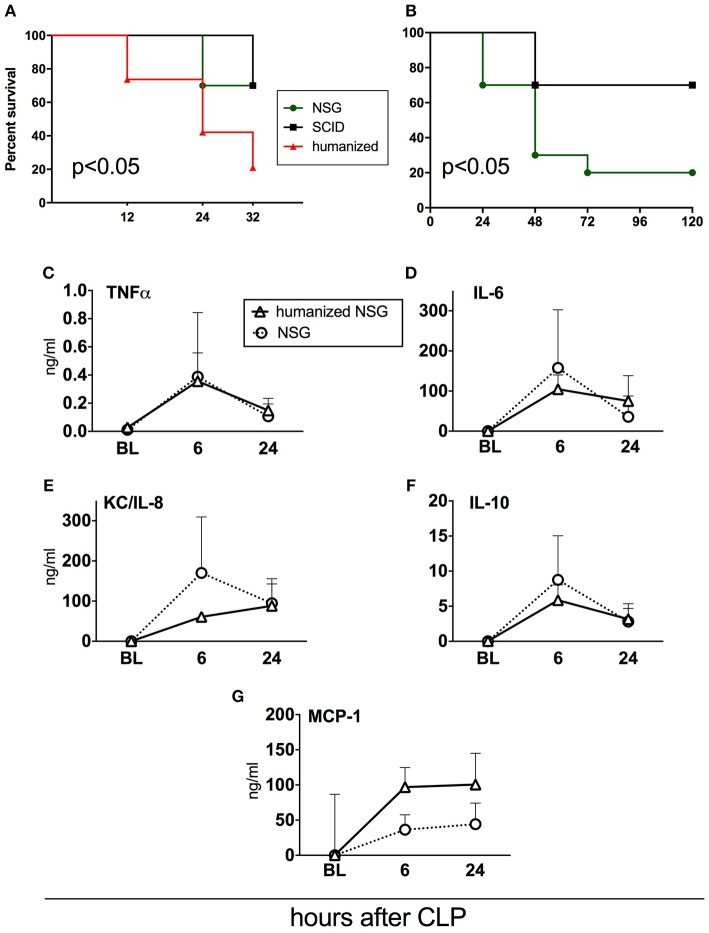
Survival and cytokine responses in humanized NSG vs. naïve NSG and SCID mice. All mice were subjected to CLP with 25G needle size. (A) Acute survival curves of hNSG (n = 19), naïve NSG (n = 10), and SCID (n = 10). Humanized NSG mice were terminated at 32 h post-CLP for tissue collection and analysis. Survival curves were compared by Log-rank test, p < 0.05 for hNSG vs. NSG and vs SCID. (B) Long-term survival curve of NSG and SCID mice from the same experiment. (NSG n = 10, SCID n = 10, hNSG n = 19). Survival curves were compared by Log-rank test, p < 0.05. Murine cytokine responses in NSG (n = 10) and hNSG (n = 19) G: (C) TNF; (D) IL-6; (E) KC/IL-8; (F) IL-10; (G) MCP-1. Murine cytokine levels in humanized vs. NSG mice were compared by the paired t-test at each time-point separately.